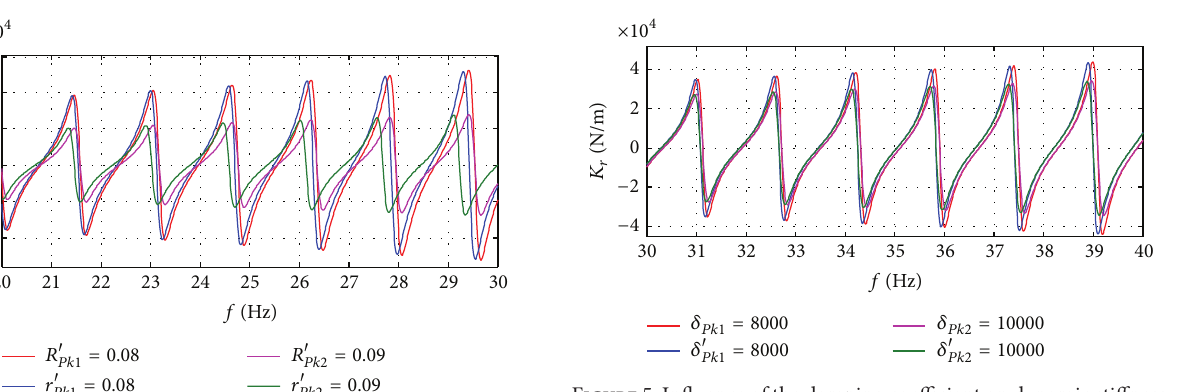
Figure 5: Influence of the damping coefficient on dynamic stiffness.